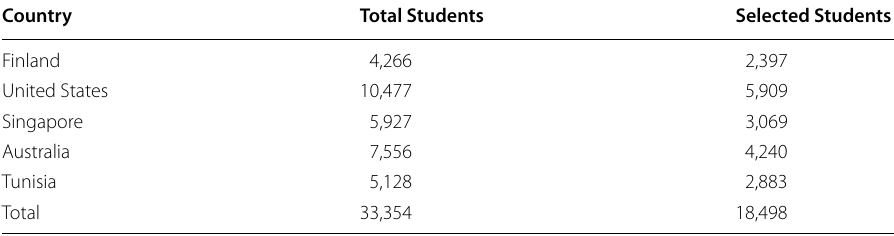
Table 1 Number of (Selected) Students of TIMSS 2011 8th Grade Mathematics Test per